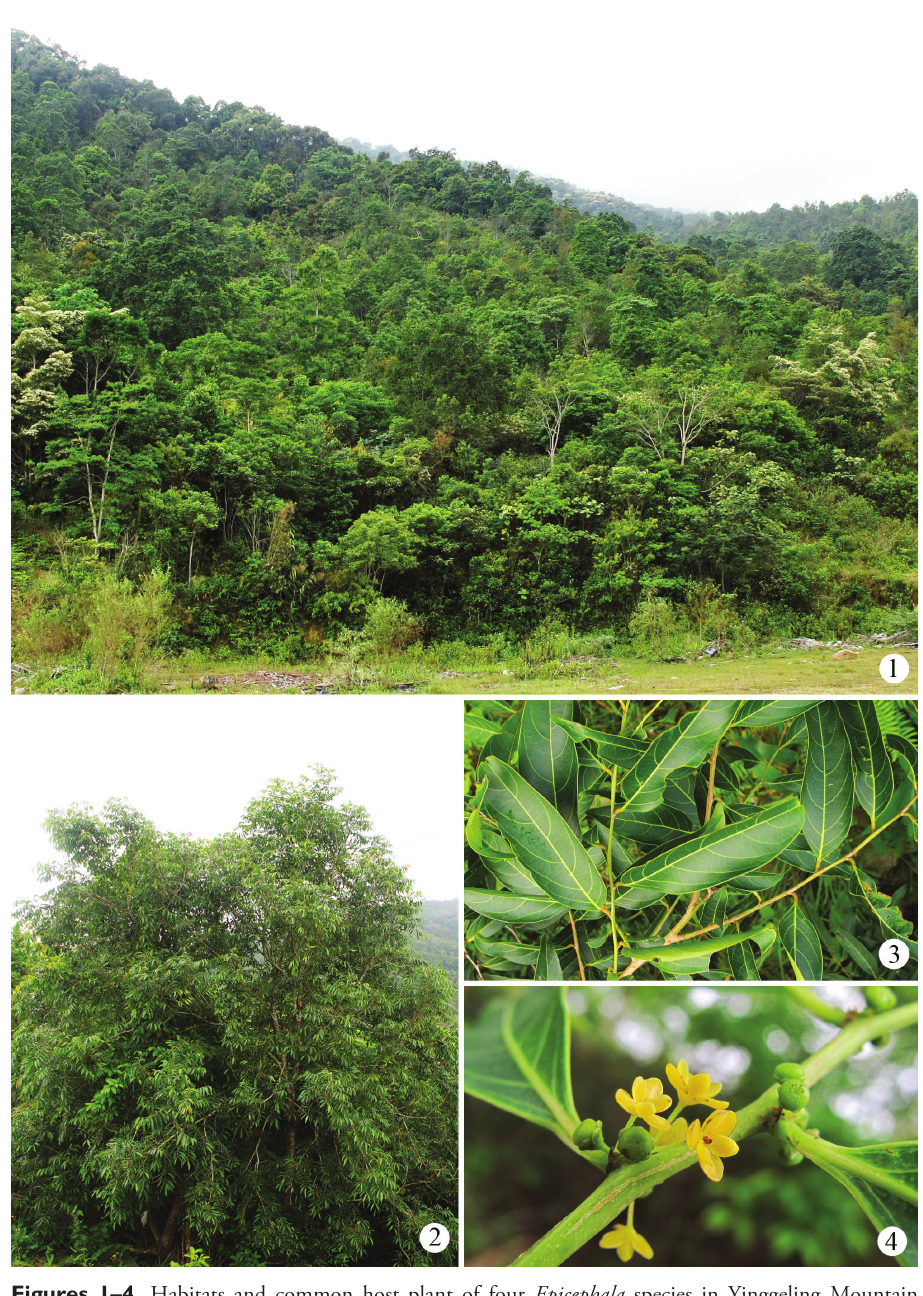
Figures 1–4. Habitats and common host plant of four Epicephala species in Yinggeling Mountain Nature Reserves, Hainan Province, China. 1 general habitat 2–4 morphological features of Glochidion sphaerogynum : 2 an individual tree 3 branches and leaves 4 male flowers and young